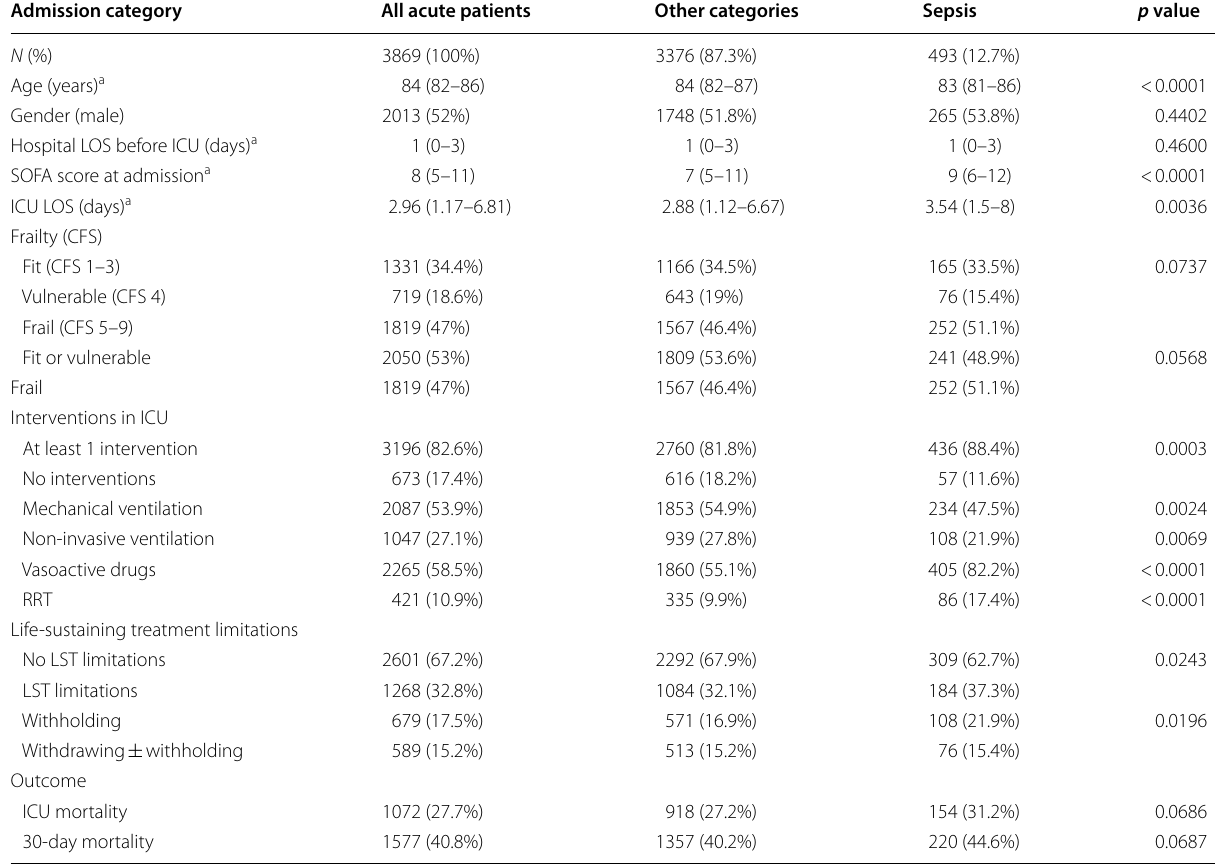
Table 1 Comparison of acute patients admitted for sepsis versus acute patients admitted for other